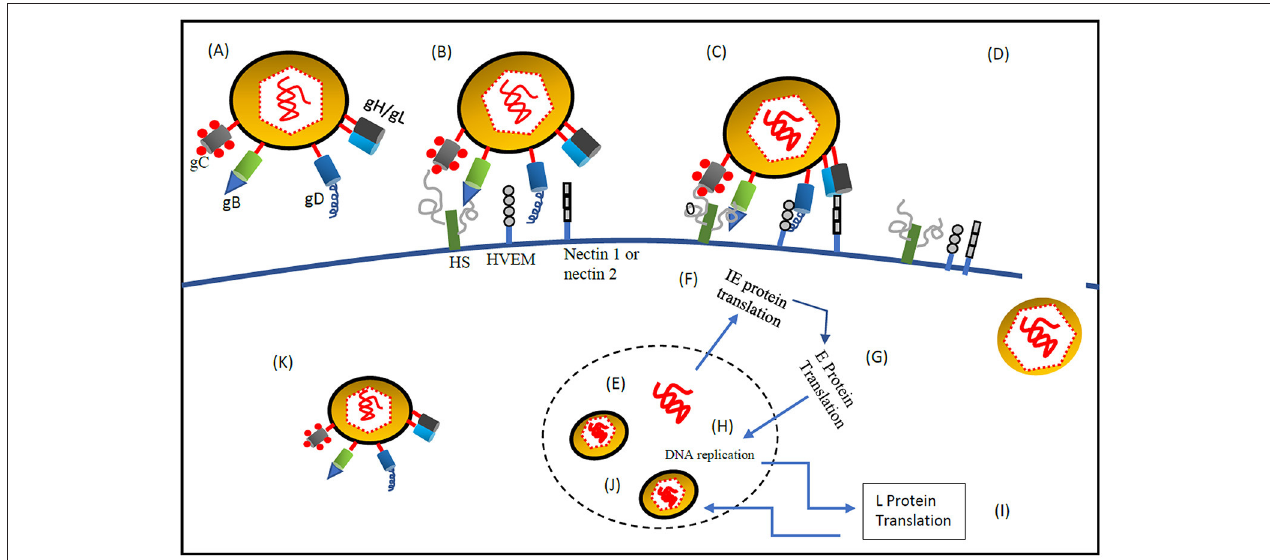
FIGURE 1 | Systemic delivery of oncolytic HSV-1 to the tumor cells by retargeting. (A) oHSV-1 contains the following components (1) Core, a dsDNA genome which is opaque to electrons and enfolded as a spool or a toroid. (2) Icosahedral capsid with 162 capsomers surrounding the core. Tegument proteins control the transport of DNA via channels in the capsid (3) Amorphous unstructured matrix of proteins called tegument (4) An outer envelope of lipid bilayer consisting of glycoprotein spikes. The envelope contains 13 types of glycoproteins ( Zhou et al., 1999; Shen and Nemunaitis, 2006). (B) At first, gC and gB interact with the host cell surface glycosaminoglycan, heparan sulfate (Herold et al., 1991, 1994; Spear et al., 1992). (C) Post gC and gB binding, gD interacts with host cell surface receptors, nectin-1a, nectin-1b, nectin-2a, nectin-2d, and HveA, which results in initiation of virions-cell fusion (Spear, 2004). (D) Fusion of envelope with host cell membrane and entry of viral DNA and capsid with associated tegument proteins. (E) Entry of viral DNA into the host nucleus (Herold et al., 1991, 1994; Spear et al., 1992). (F) Once the viral DNA enters the nucleus through the nuclear pore host RNA polymerase II initiates Viral DNA transcription. Five immediate-early (IE) genes, ICP0, ICP4, ICP22, ICP27, and ICP47, are transcribed and translated immediately ( Burton et al., 2002) stimulated by VP-16, at the same time host cell shutoff takes place. IE genes are involved in transcription and translation of other HSV genes. (G) Before the viral DNA synthesis occurs, Early (E) genes transcribe and translate viral SSBP, DNA helicase, origin binding protein, DNA polymerase and localize them into the nucleus. (H) DNA replication is origin dependent having three origin sequences. DNA replication takes place in subnuclear constructions called, replication compartments. At the end of the replication cycle, a concatemeric DNA is formed (Mocarski and Roizman, 1982). (I) Late gene transcription and translation which produces structural components of the HSV-1 virus. (J) Mature virion formation- capsid assembly and encapsidation of concatemeric DNA takes place by systematic cleavage of the concatemeric DNA. Maturation and release of virions is done through Golgi apparatus (egress). (K) The fully mature HSV-1 virus is then released from secretory vesicles (Shen and Nemunaitis,